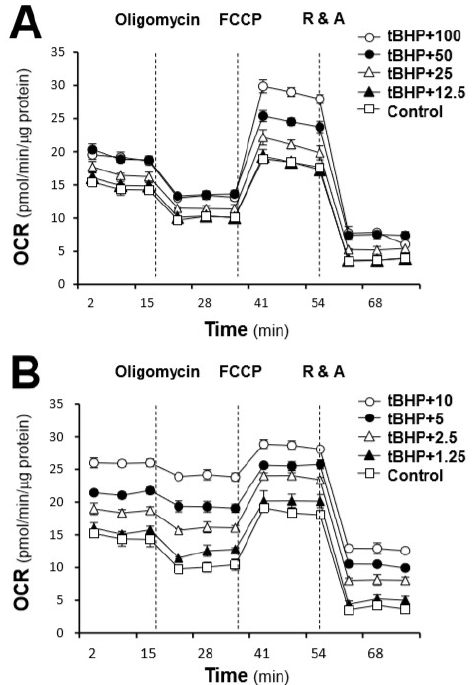
Figure 7. Effects of the major compounds of AR, i.e., ( A ) astragaloside IV and ( B ) genistein, on tBHP-treated H9C2 cells against oxidative stress. Cultured H9C2 cells were pre-treated with astragaloside IV (0–100 μM) and genistein (0–10 μM) for 24 h before being exposed to tBHP (30 μM) for 1 h. The OCR values were normalized with respect to the cellular protein content. The control was tBHP-treated cultures. The data are expressed as mean ± SD, n = 3, each with triplicate samples.